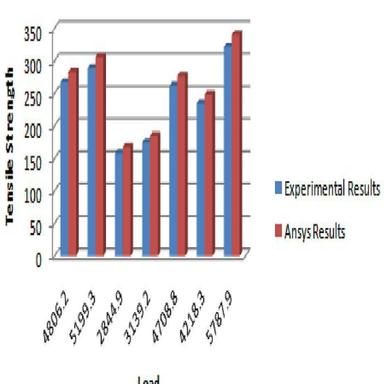
Comparison of Tensile Strength of C–C Laminate specimen using Experimentation and Ansys.